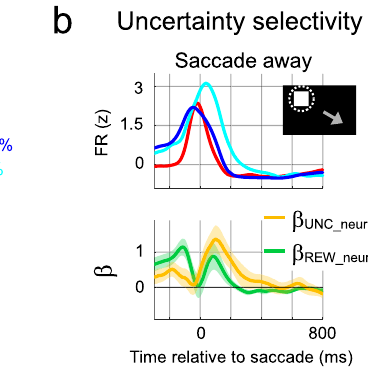
suf fi cient trials; 0%; n =31; 50%: n =26; 100%: n =21). Gray bar along the x -axis indicates time window used for statistics. b Effects of reward and uncertainty for saccades away from a mask in the RF (cartoon). PSTHs (top) and reward and uncertainty coef fi cients (bottom) aligned on saccade onset (mean and ±2 SEM, n =26 cells with suf fi cient number of trials). Other conventions as in Fig. 2. The correlation of UNC and REW regressors ranged between − 0.04 and 0.1, and was never signi fi cant. Source data are provided as a Source Data fi